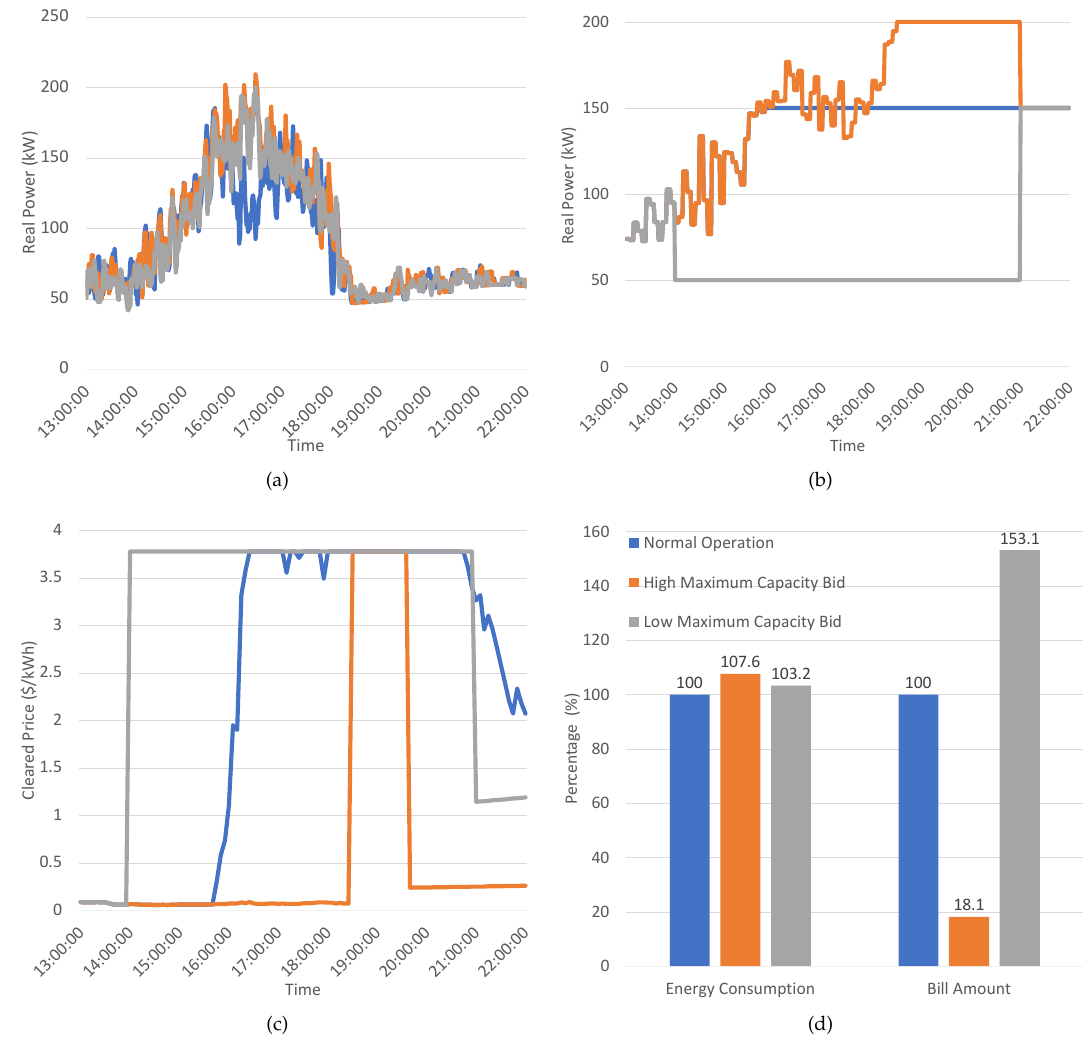
Figure 6. Injection Attack with IEEE 13 Node: ( a ) total load, ( b ) current market-clearing quantity, ( c ) current market-clearing price, and ( d ) economic impact of the